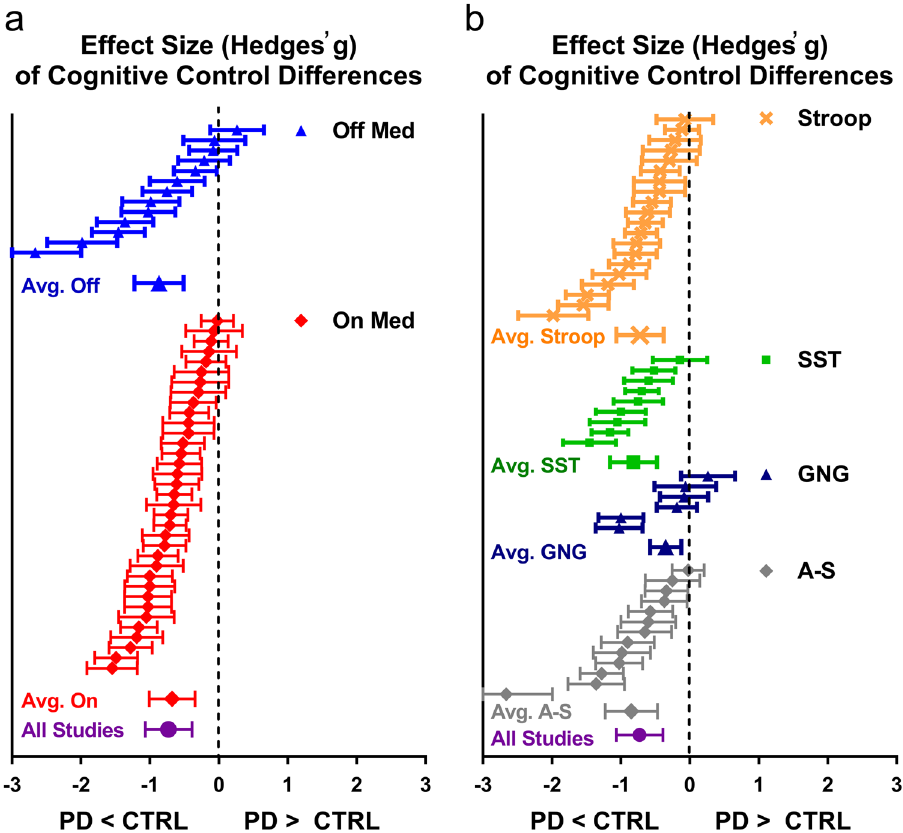
Fig. 2 Forest plot of effect sizes for all studies that compared performance on a response inhibition task between a PD group and a matched healthy control group. a Studies sorted by medication status. b Studies sorted by task. Effect sizes to the left of the vertical dashed line indicate that performance of the PD group was poorer than controls. Note: Avg., Average; SST, Stop-Signal Task; GNG, Go-NoGo; A-S,